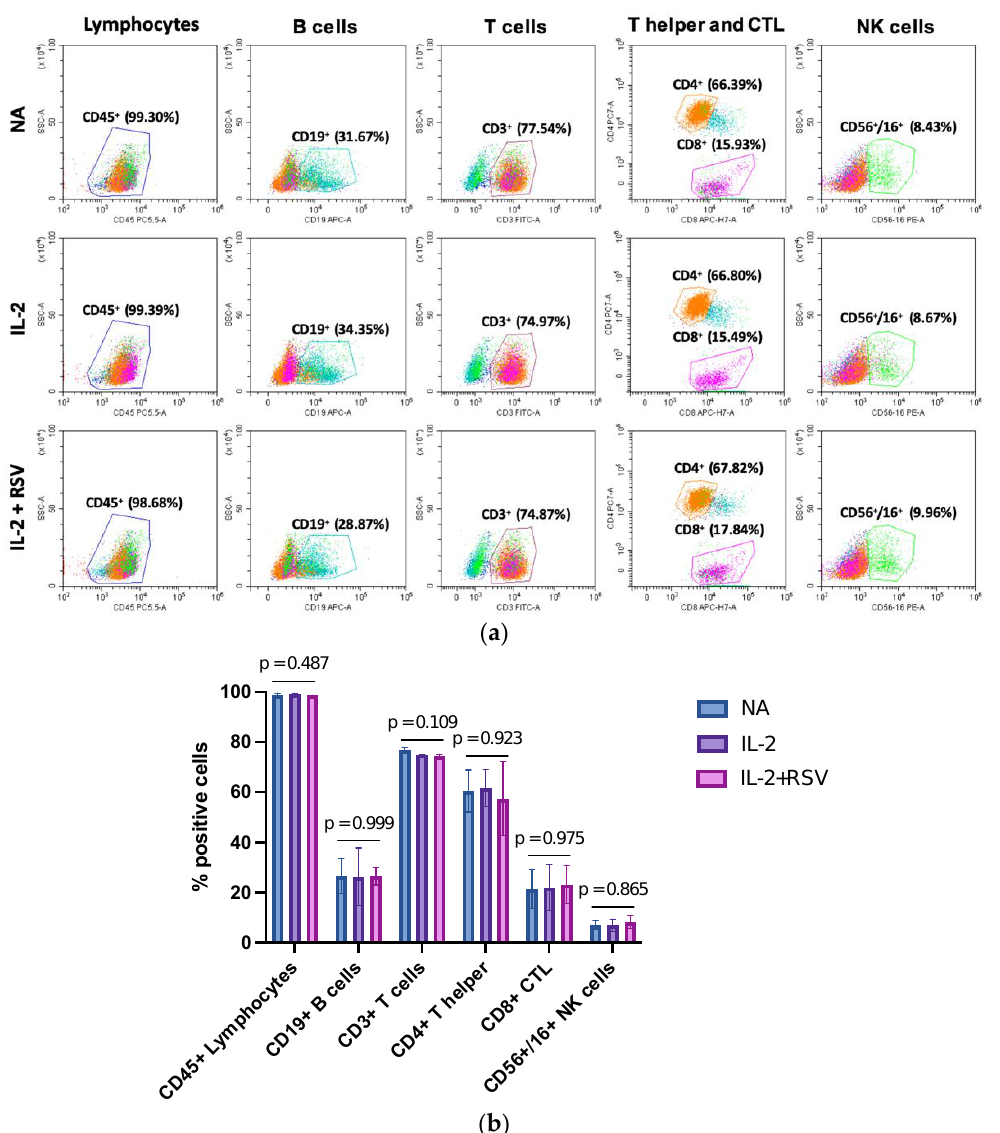
Figure 2. Effect of RSV on the lymphocyte populations. Lymphocytes obtained from 13 menopausal women were activated with IL-2 in absence or presence of RSV. Non-activated lymphocytes (NA) represented an internal control. ( a ) Flow cytometry graphs representative of the 13 different experiments. ( b ) Percentage of the different lymphocytic subpopulations. Data are expressed as mean ± standard deviation. CTL = cytotoxic T lymphocytes; NA = not activated; IL-2 = activated with IL-2 only; IL-2 + RSV = activated with IL-2 and RSV. The p -values represent the ANOVA results.